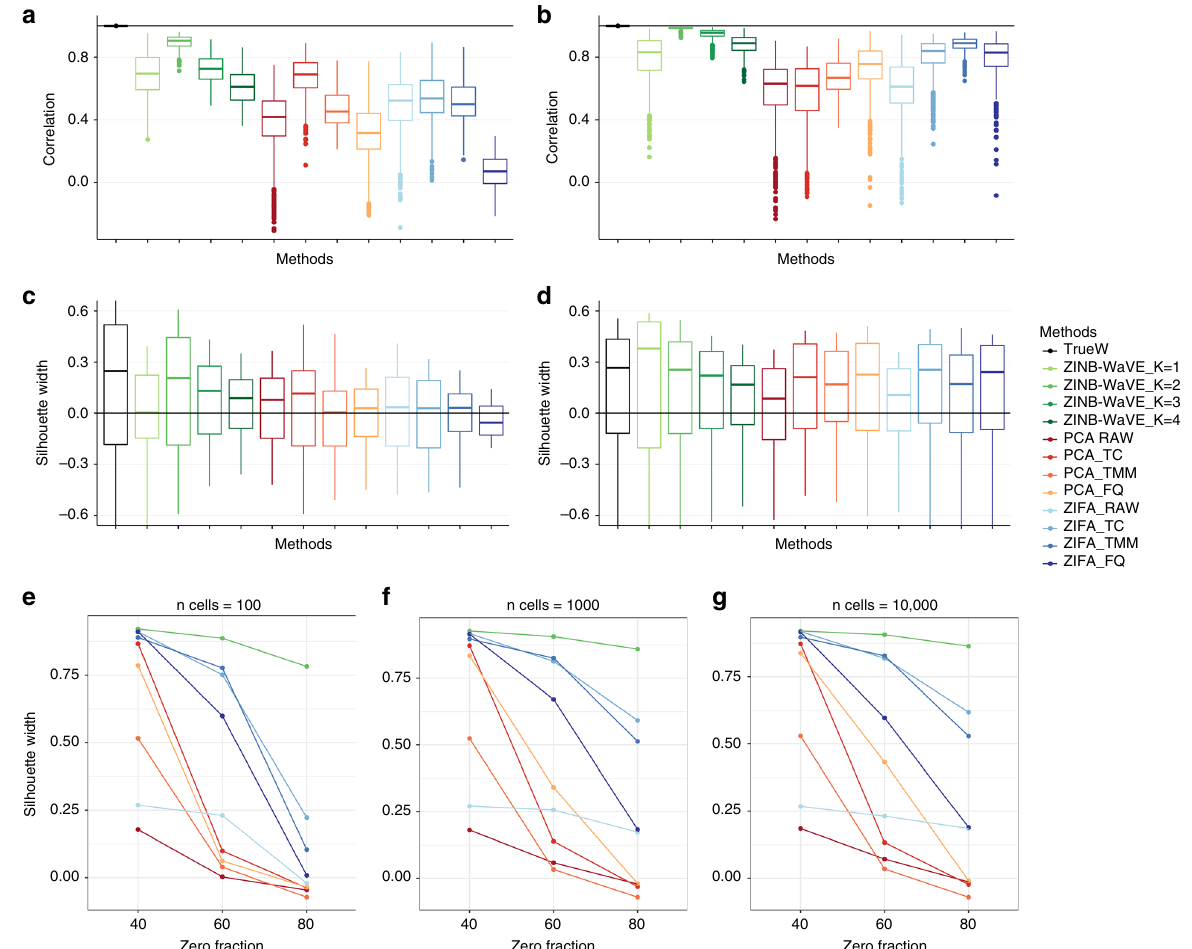
Fig. 7 Between-sample distances and silhouette widths on simulated data. a Boxplots of correlations between between-sample distances based on true and estimated low-dimensional representations of the data for simulations based on the V1 data set. b Same as a for simulations based on the S1/CA1 data set. c Boxplots of silhouette widths for true clusters for simulations based on the V1 data set. d Same as c for simulations based on the S1/CA1 data set. For a – d , all data sets were simulated from our ZINB-WaVE model with n = 1000 cells, J = 1000 genes, “ harder ” clustering ( b 2 = 5), K = 2 unknown factors, zero fraction of about 80%, X = 1 n , cell-level intercept ( V = 1 J ), and genewise dispersion. Each boxplot is based on n values corresponding to each of the n samples and de fi ned as averages of correlations ( a , b ) or silhouette widths ( c , d ) over B = 10 simulations. See Supplementary Fig. 27 for the same scenario but with n = 10,000 cells and Supplementary Fig. 28 for additional scenarios. e – g Average silhouette widths (over n samples and B = 10 simulations) for true clusters vs. zero fraction, for n ∈ {100;1000;10,000} cells, for data sets simulated from the Lun & Marioni 42 model, with C = 3 clusters and equal number of cells per cluster. Although ZINB-WaVE was relatively robust to the sample size n and zero fraction, the performance of PCA and ZIFA decreased with larger zero fraction. Between-sample distance matrices and silhouette widths were based on W for ZINB-WaVE, the fi rst two principal components for PCA, and the fi rst two latent variables for ZIFA. ZINB-WaVE was applied with X = 1 n , V = 1 J , genewise dispersion, and K ∈ {1, 2, 3, 4} (only K = 2 is shown in e – g . For PCA and ZIFA, different normalization methods were used. Colors correspond to the different (genewise or common), even though the data were simulated with genewise dispersion (Fig. 6). The estimators for ln( μ ) and π were unbiased over the whole range of mean expression and zero in fl ation probability (Supplementary Fig. 26).